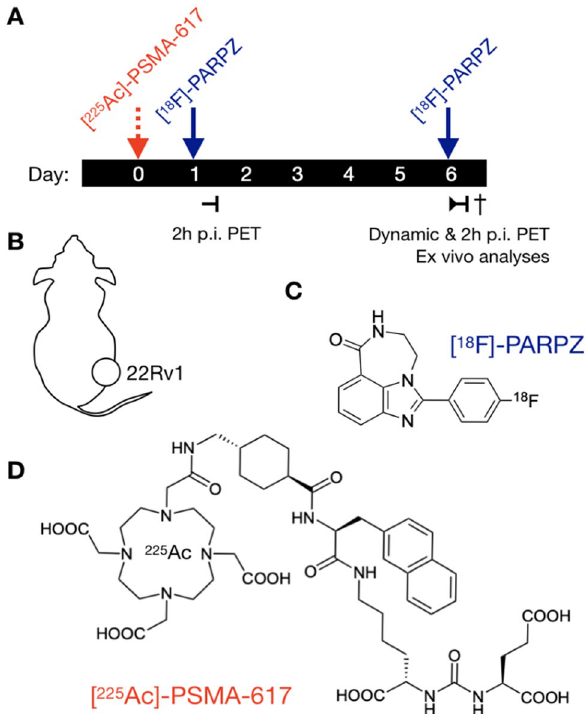
Figure 1. Schematic of Study Design. A) PSMA-expressing 22Rv1-Luc subcutaneous xenograft were implanted into NCI athymic Nu/Nu male. Upon reaching approximately 500 mm3, either control saline or the potent targeted [ 225 Ac]-PSMA-617 was administered. Static [18F]PARPZ-PET was performed at 1 and 6 d post-therapy (n = 8), and dynamic imaging for group matched animals (n = 3). Chemical structures of A) the PARP-1 specific [18F]-PAPRZ radiotracer and B) the prostate cancer targeting [ 225